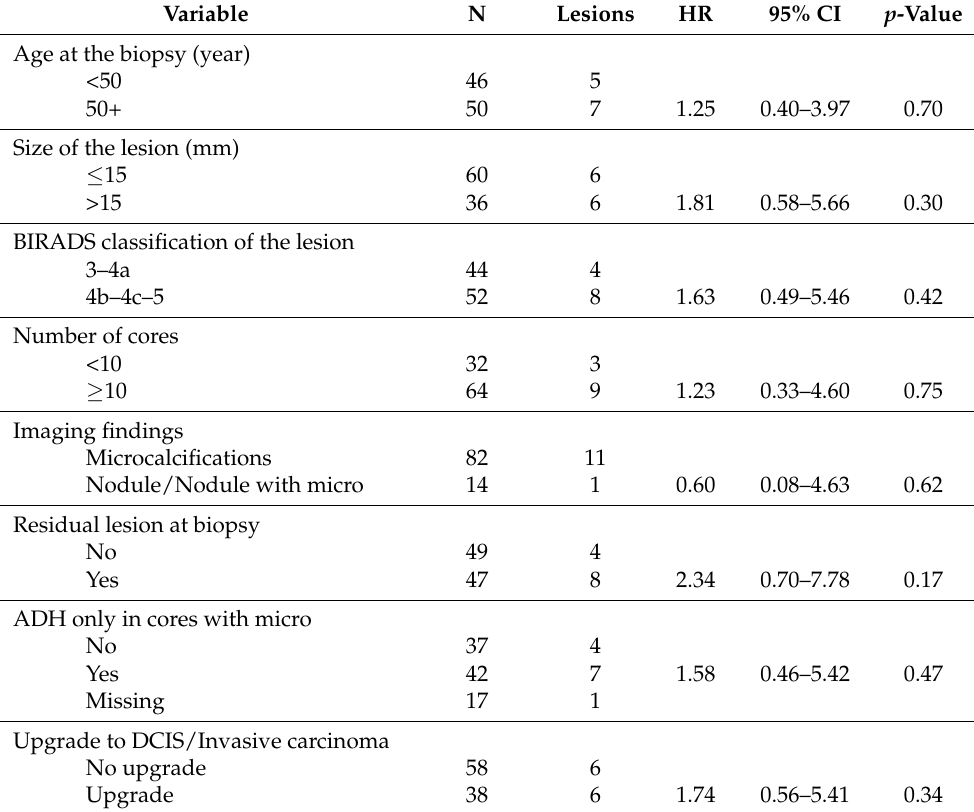
Table 5. Association between patients’ characteristics and incidence of lesion (univariate analysis) (N = 96).